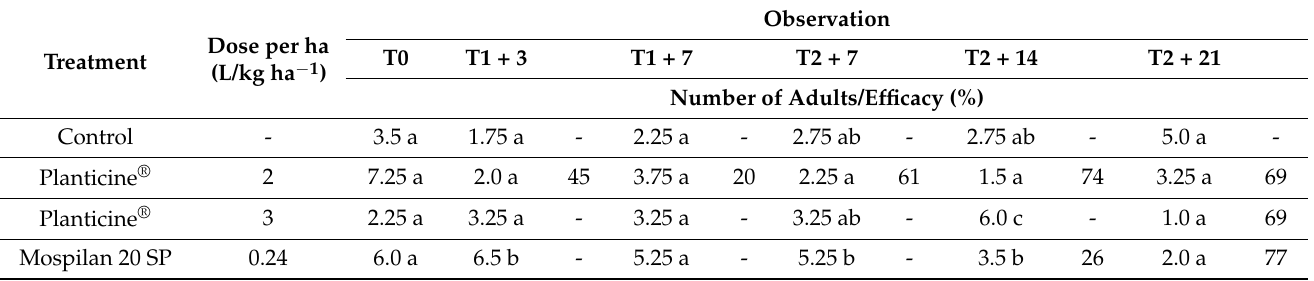
Table 4. Number of adults of Frankliniella occidentalis on tomato leaves and efficacy of their reduction depending on the application of Planticine ® and chemical